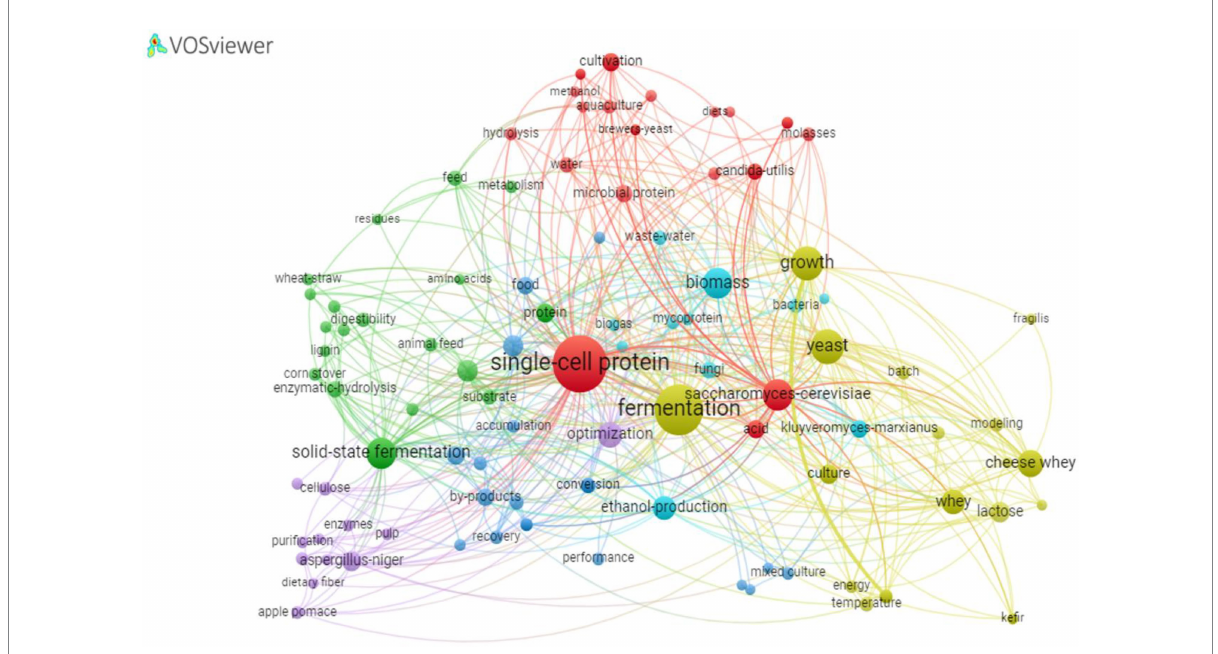
FIGURE 7 Network map showing correlations between the most used keywords in the articles based on the keywords and Boolean operators “fermentation” and “single cell protein” or “single cell